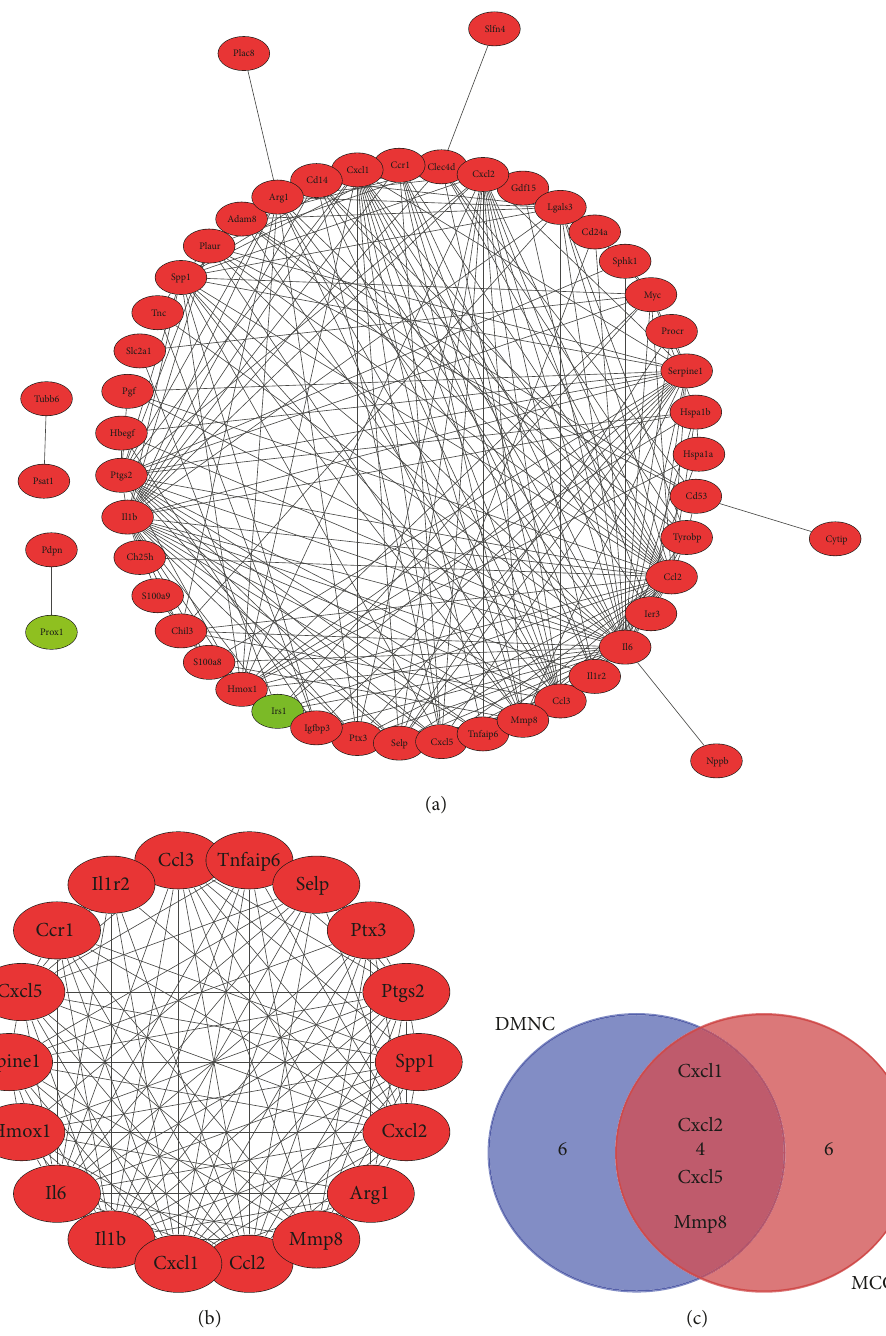
Figure 6: Establishment of PPI network, modules analysis, and Venn diagram. (a) Whole PPI network. Circles and lines represent genes and the interaction of proteins between genes, respectively. The red represents the upregulated genes. The green represents the downregulated genes. (b) PPI network of module. Circles and lines represent genes and the interaction of proteins between genes, respectively. The red represents the upregulated genes. (c) Venn diagram of mutual hub genes based on two methods. Abbreviation: PPI, protein-protein